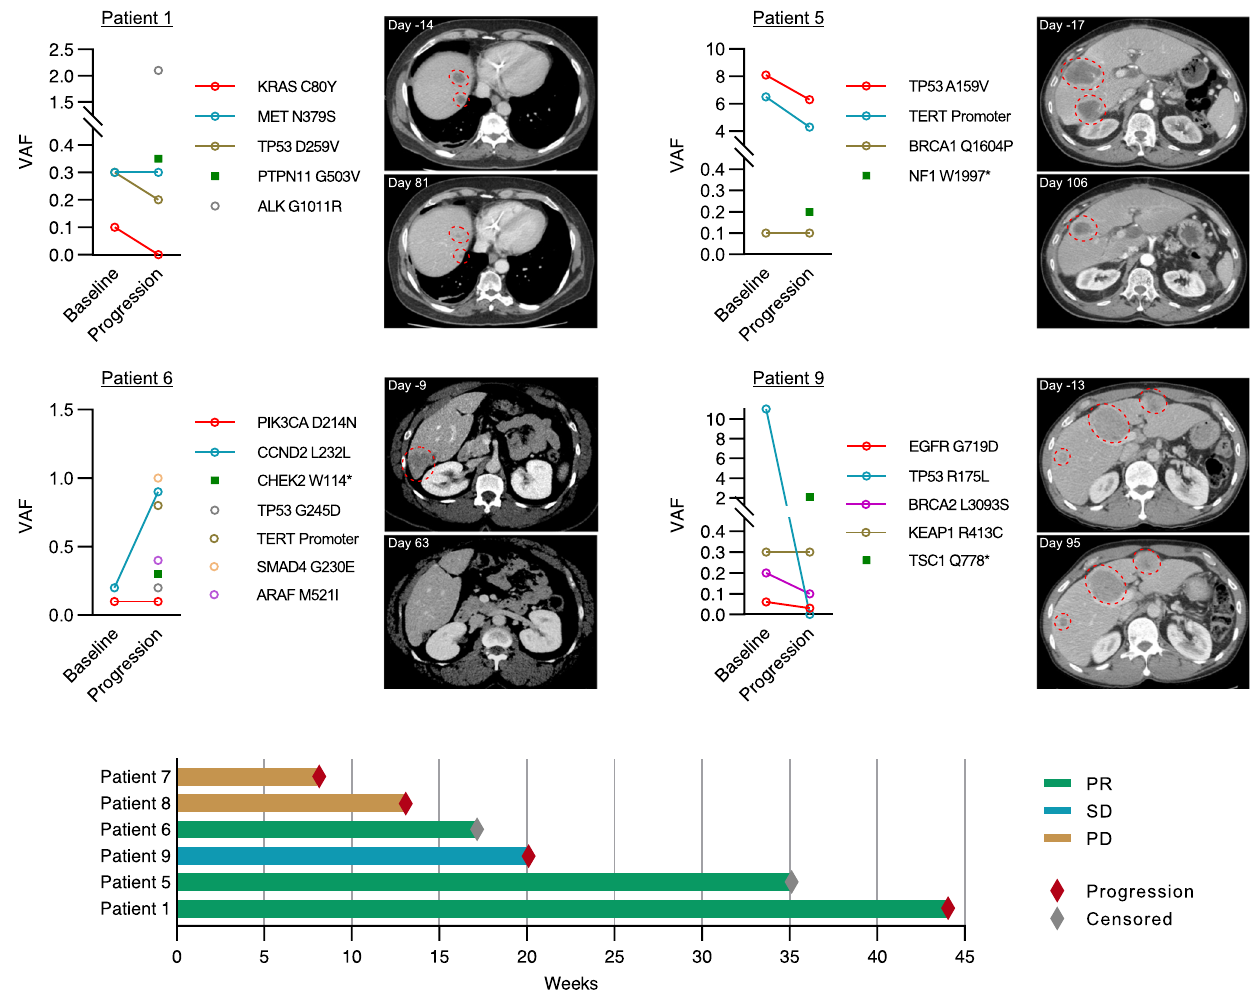
Fig. 5 | Outcomes of patients receiving matched therapies to emergent ctDNA alterations. ctDNA alterations at baseline and progression are shown in dot plots with emergent alterations targeted by matched therapies shown as green squares. Representative target lesions denoted by red dotted outlines are shown on axial slices from computerized tomography scans prior to and after receiving matched